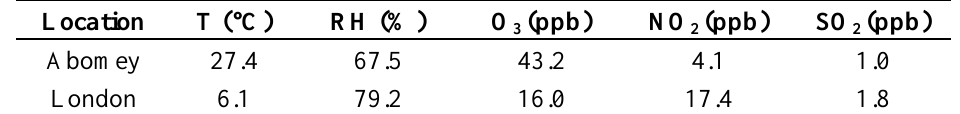
Table 2. Average temperature, relative humidity and pollution levels measured in London and Abomey over 140 days between November 2012 and April